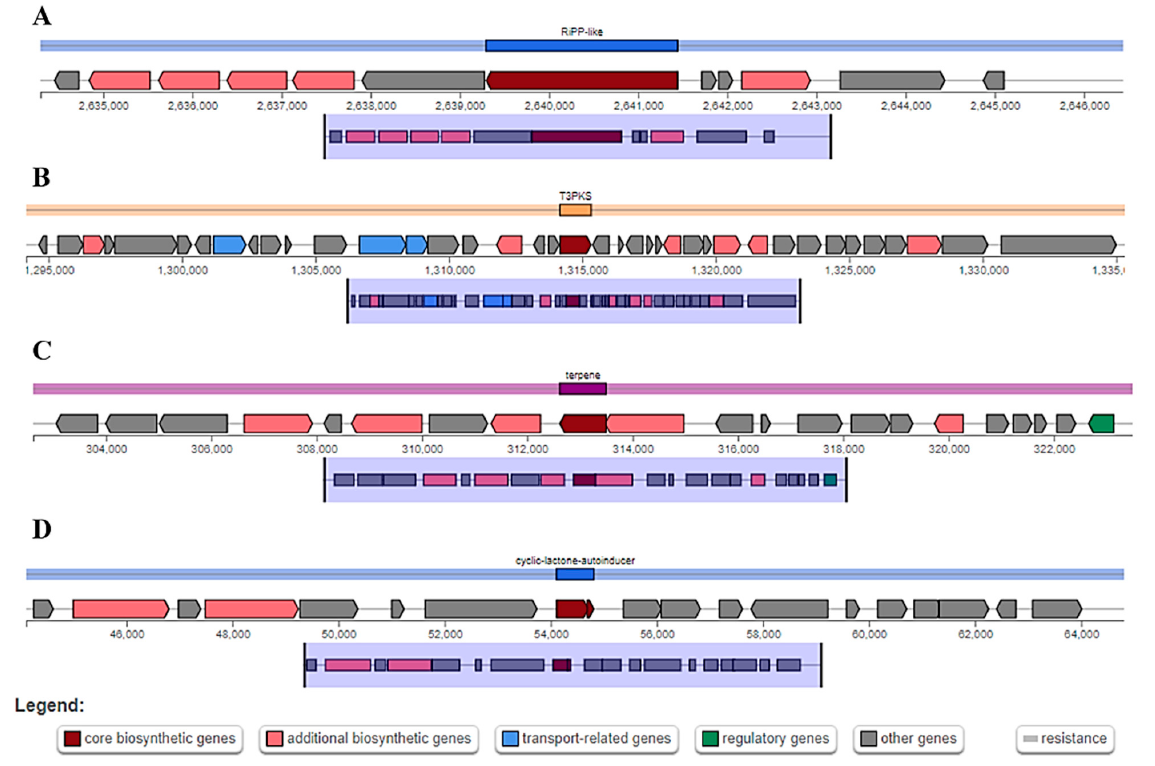
Figure 9. Bacteriocins and secondary metabolite ‐ producing regions in genome of L. plantarum 13 ‐ 3. Red (core biosynthetic genes), pink (additional biosynthetic genes), green (regulatory genes), blue (transport ‐ related genes), grey (other genes). ( A ) cyclic lactone autoinducer. ( B ) Terpene. ( C ) T3PKS. ( D ) RiPP ‐ like.